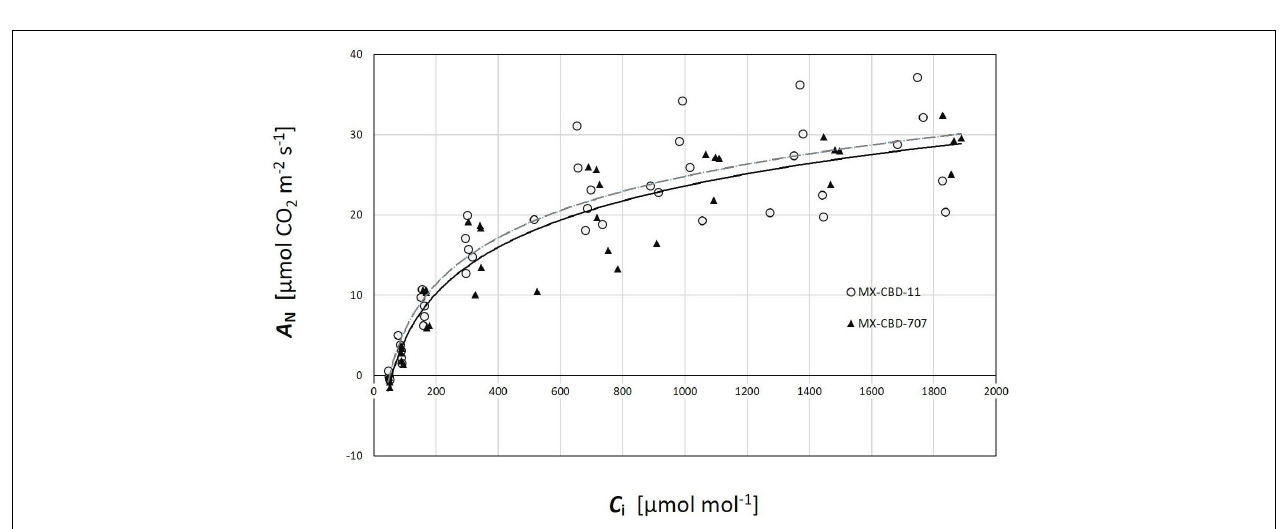
FIGURE 5 | Photosynthetic light response ( AQ ) curves of two breeding populations of medical cannabis: MX-CBD-11 and MX-CBD-707. The data points indicate measurements on individual plants (5 plants of each population).